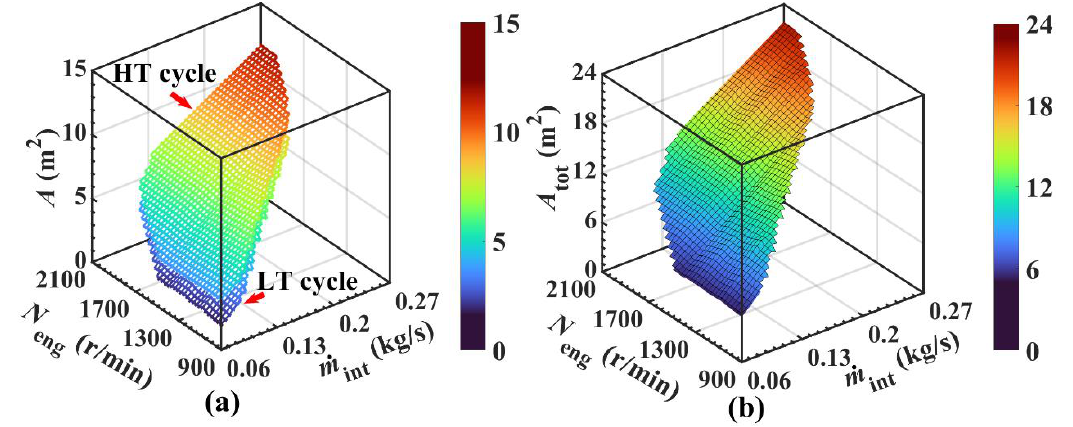
16 of 30 Figure 7. Influence characteristics of key variables on system power output. (a) Effect characteris- tics of inlet temperature of a condenser on the system power in a different cycle. (b) Effect charac- teristics of parameter of expander on system power in HT cycle. 4.3. Heat Transfer Surface Analysis 4.3.1. Variable Working Conditions Figure 8 shows the analysis of heat transfer surface characteristics of the HT cycle, LT cycle and system under variable working environments. Figure 8a shows the analysis of heat transfer surface for different loops. With the increase of speed, heat transfer surface